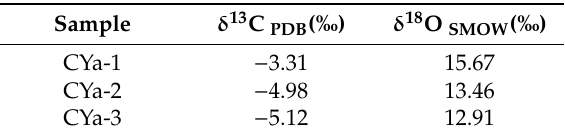
Table 5. Carbon and oxygen isotope composition of calcite samples from Yalguba Ridge agates.